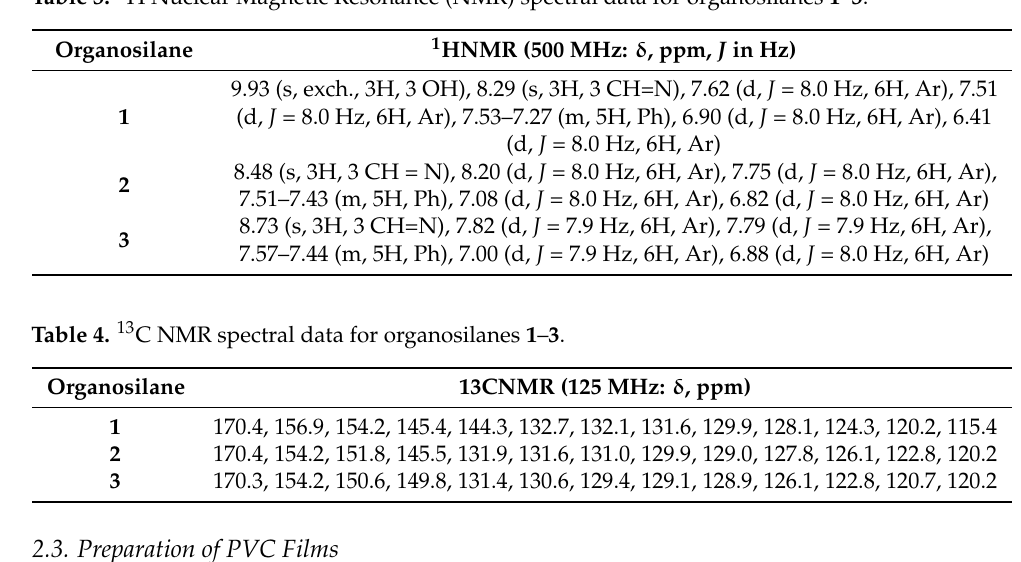
Table 3. 1 H Nuclear Magnetic Resonance (NMR) spectral data for organosilanes 1 – 3 .